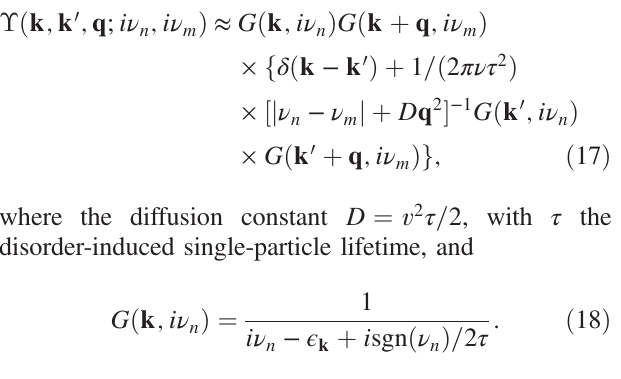
ffiffiffiffiffiffiffiffiffi p 2 m μ